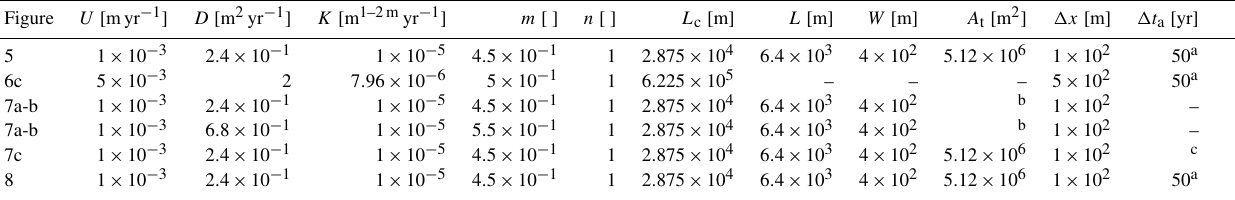
Table 1. Table of model parameters. U : uplift rate; D : diffusion coefficient; K : erodibility coefficient; m and n : drainage area and slope exponents, respectively; L c : distance to the center of model domain; L : distance between confluences; W : valley width; A t : tributary area; (cid:49)x : node spacing; (cid:49)t a : time between avulsions; a only for models with avulsions; b varying drainage area with the lowest value being the same as the drainage area of a single non-confluence node (i.e., W × (cid:49)x ) and with all following values ranging from 2 to 20 segment areas (i.e., L × W ) in steps of 2 × L × W ; c varying time between avulsions (between 50 and 950 years in intervals of 100 years).